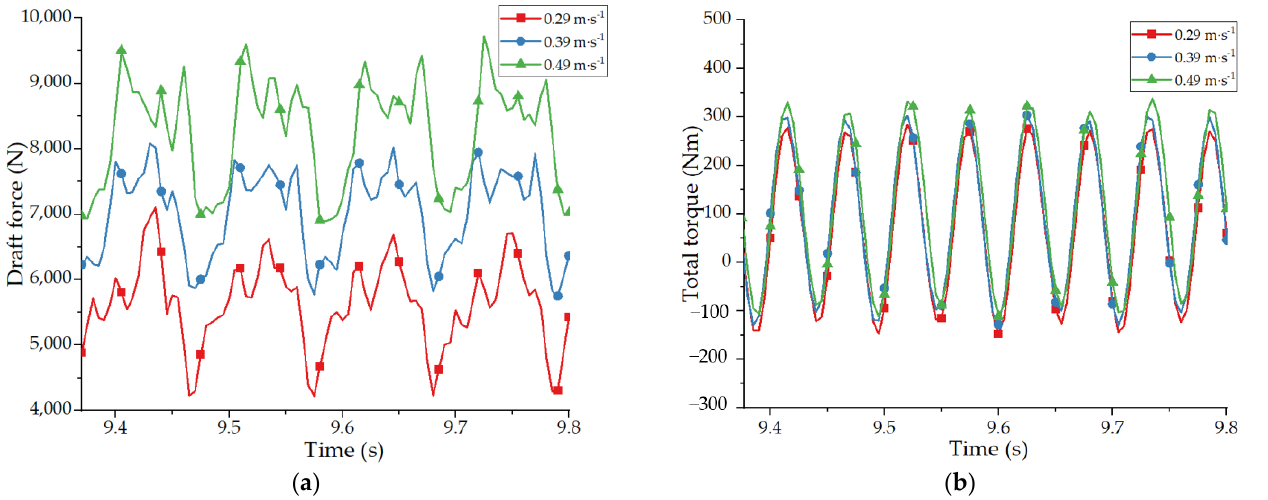
Figure 11. Effect of forward speed on harvester performance: ( a ) Draft force; ( b ) Total torque.